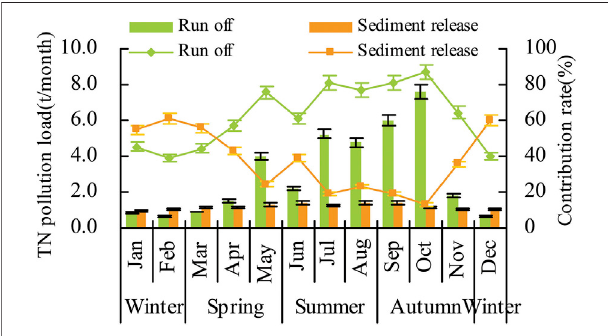
FIGURE 4 | Monthly variations in the reservoir ’ s TN contribution rate from two